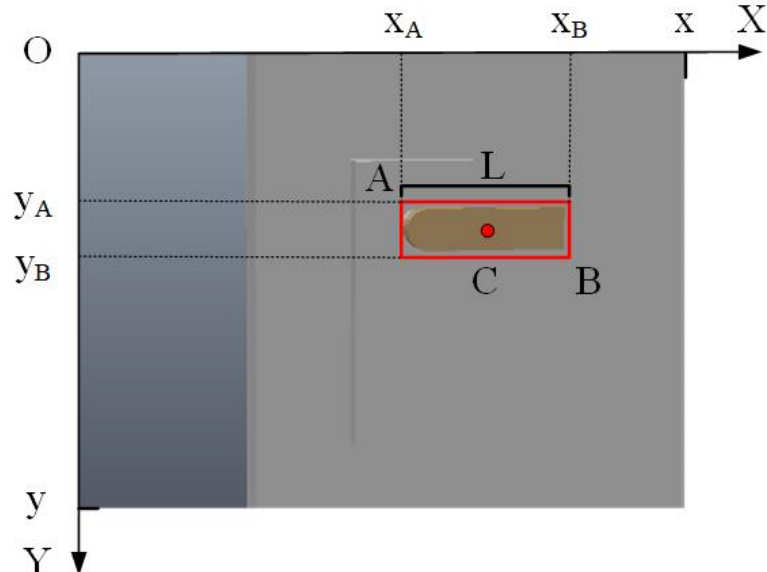
Figure 3. The object recognition of the N state.